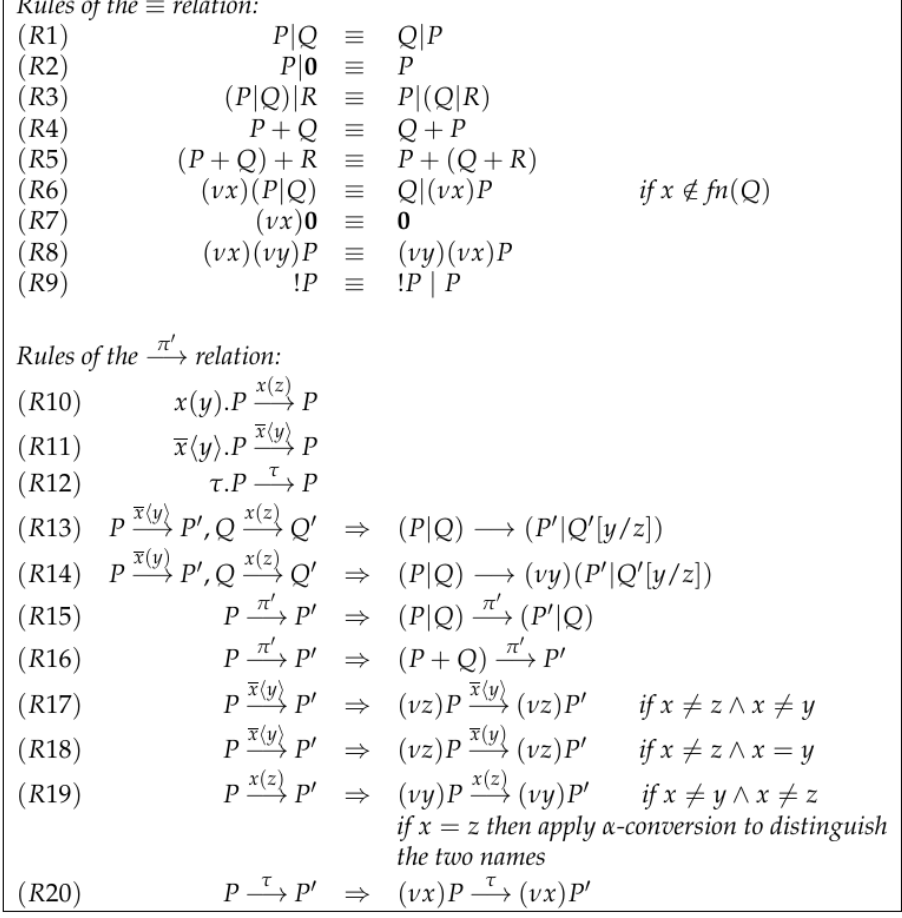
Figure 1. Rules of the structural operational semantics for the π